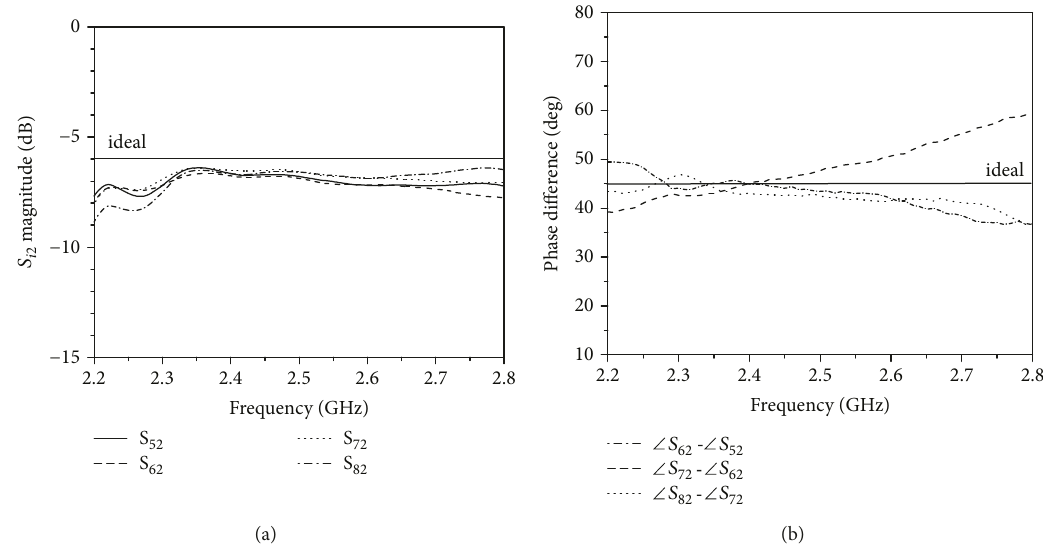
Figure 7: (a) Magnitude and (b) phase di ff erence of the S -parameters for the 4 × 4 BM when input port 2 is excited. 1.70−40−35−30−25−20−15−10−50